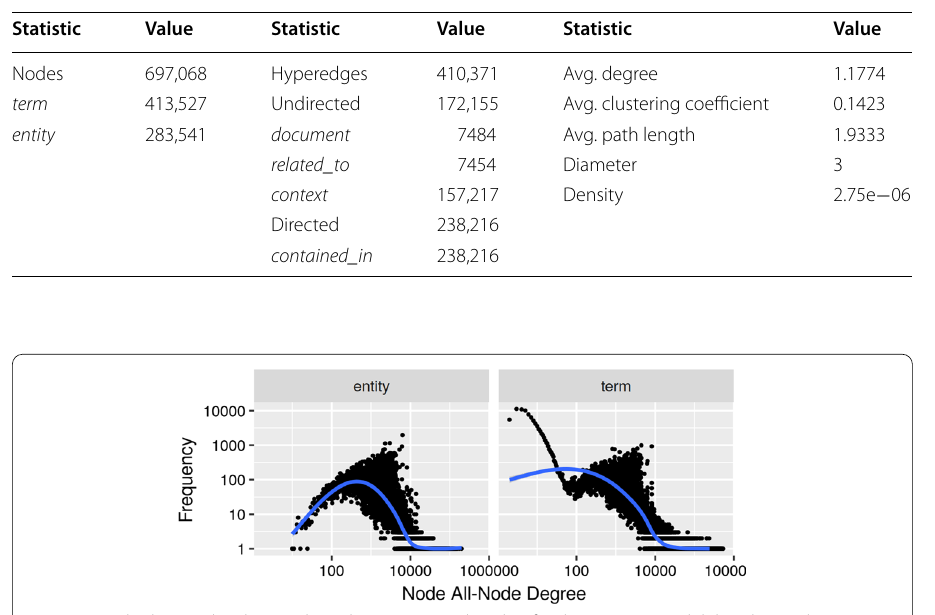
Fig. 17 Node degree distribution, based on connected nodes, for the context model (log–log